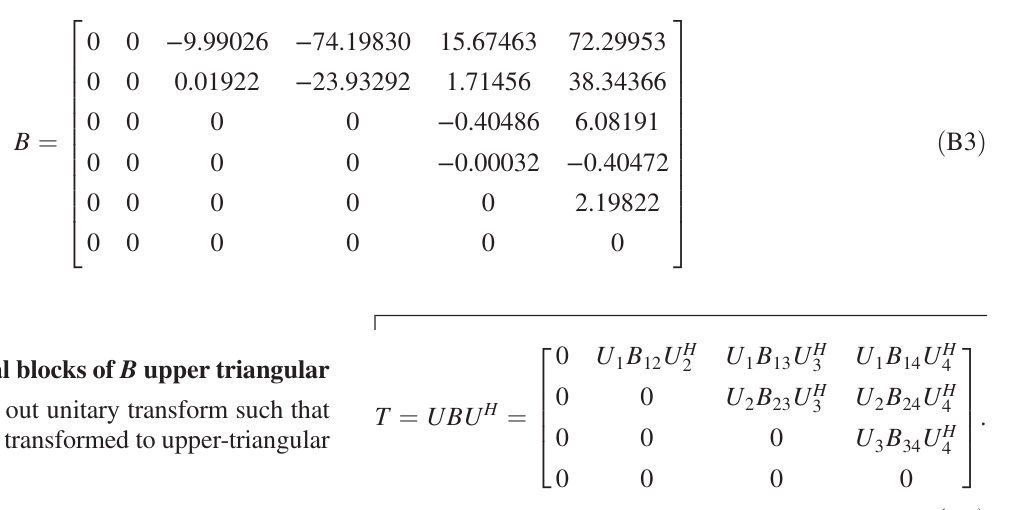
Table I: m 1 ¼ n 1 ¼ 2 ) singular values are zeros. Then